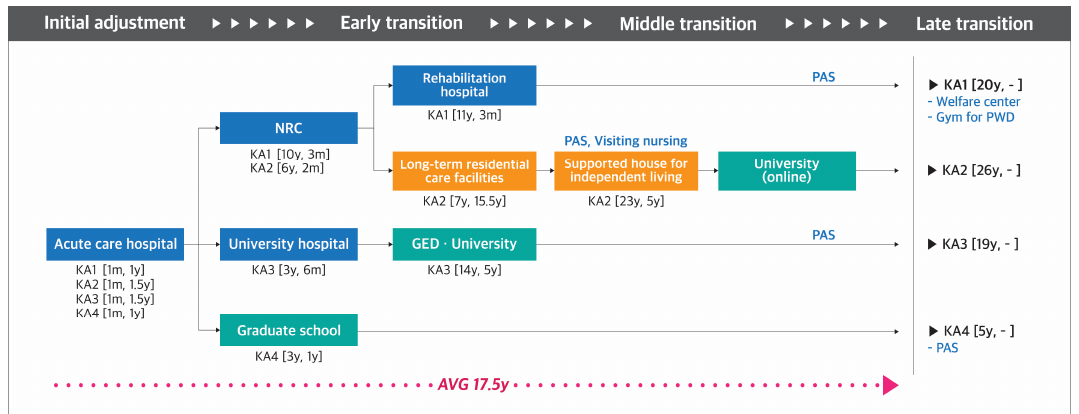
Figure 4. Pathway mapping for South Korean individuals with acquired disability. NRC, National Rehabilitation Center; GED, general equivalency diploma; PAS, personal assistance services. Note. Blue, orange, orange, green and grey color in the square respectively indicate facilities providing medical, welfare, education, and mixed medical and welfare related services. Code and number indicate participant code [the time taken to begin using the facility, the period of use] (Ex. KA1 [11y, 3m]).